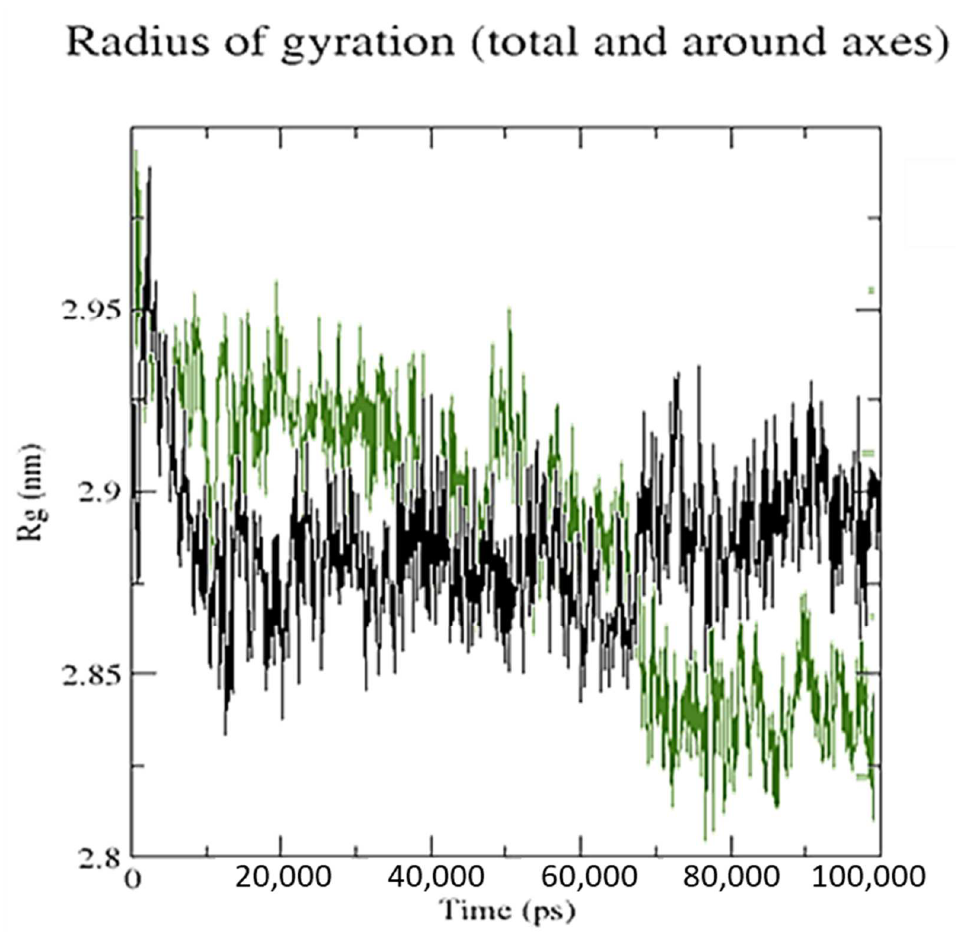
Figure 14. The radius of gyration (Rg) for SRXD complex (black) and CTcD complex (green) during 100 ns simulation time.